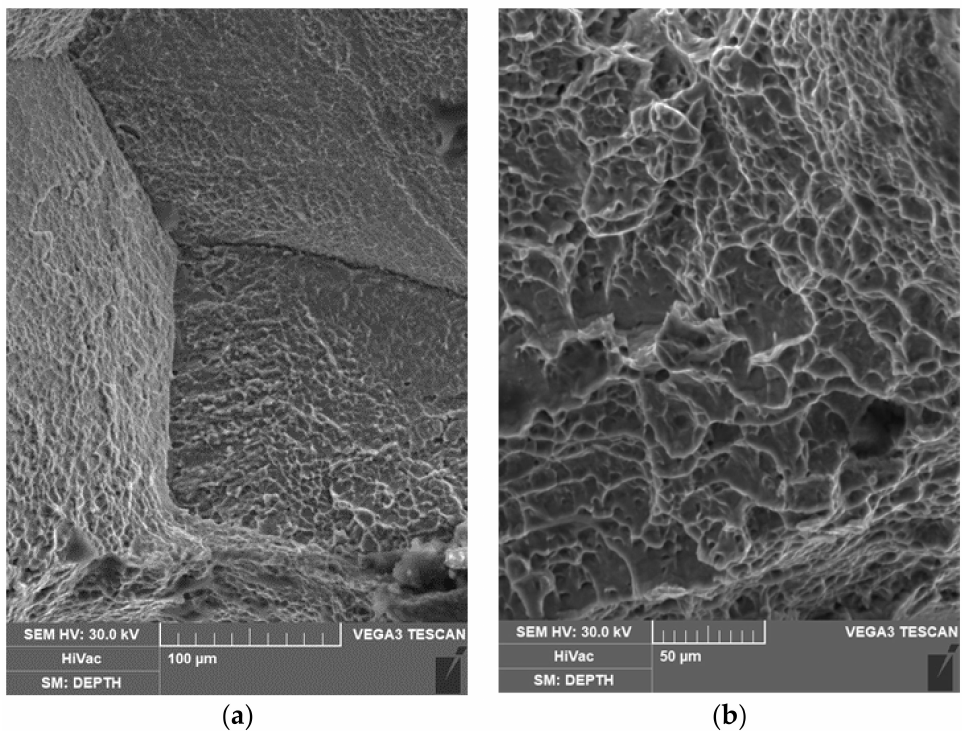
Figure 11. SEM fractographic analysis of the rupture surface of the sample tested under 275 MPa al low ( a ) and high ( b )